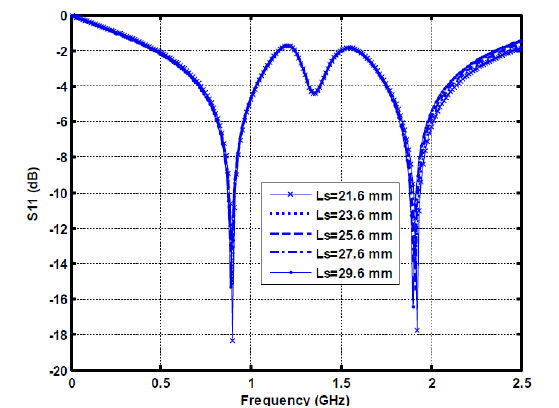
Figure 9: Variation of reflection coeflcient (dB) with frequency on varying length of microstrip ( L s